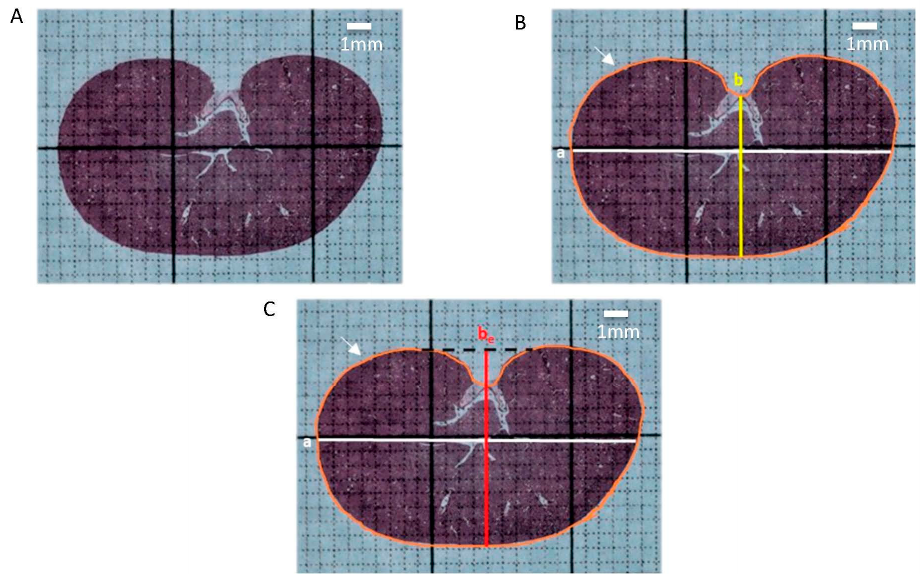
Figure 1. Renal parenchymal area. ( A ) An H&E-stained coronal section (4×) superimposed on a 1 mm 2 grid from the left kidney of a male obese ZSF1 rat. ( B ) The same renal section with labeled axes: white horizontal line represents major axis (a), yellow vertical line representing minor axis (b). The orange/brown outline around the kidney (white arrow) represents the measured renal parenchymal area, A m . ( C ) Again, the same renal section but with the minor axis extended (b e ) past the hilum (red line) to meet the imaginary dashed bar.